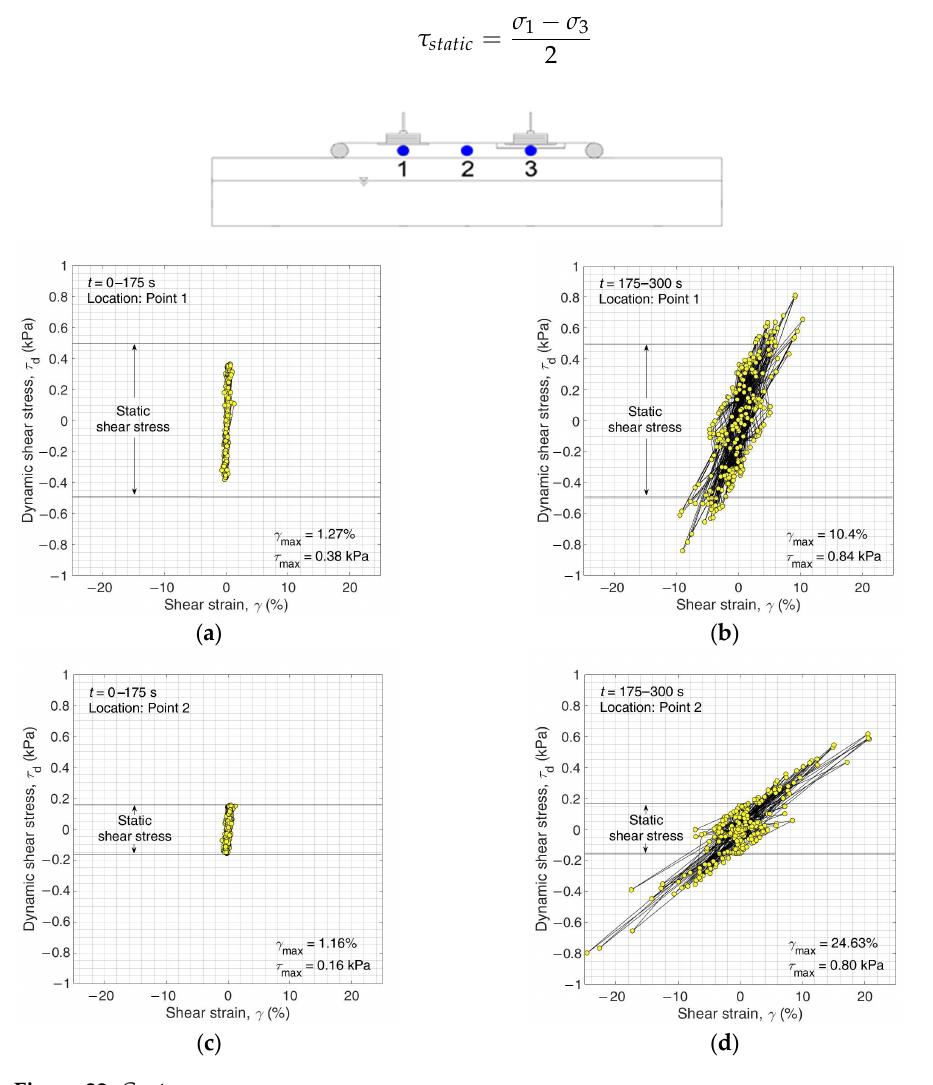
( f ) Figure 22. Shear stress-shear strain relationships: ( a ) point 1 at t = 0–175 s, ( b ) point 1 at t = 175–300 s, ( c ) point 2 at t = 0–175 s, ( d ) point 2 at t = 175–300 s, ( e ) point 3 at t = 0–175 s, and ( f ) point 3 at t = 175–300 s. 4. Conclusions In this study, a simple shaking table apparatus was developed to investigate the be- havior of shallow foundations laid on a liquefiable embankment. Based on the results of the experiment, the following conclusions are drawn: • The liquefaction of the embankment was a reaction to the liquefaction of the outside soil as water seeped into it, showing the susceptibility of Saemangeum silty sand to seepage-induced liquefaction, even at a partially saturated state. It was observed that at t = 0 s to 200 s, pore pressure rise at PP-B and PP-D of the embankment was negli- gible. A sudden rise in pore rise was then observed at t = 200 s to 300 s.